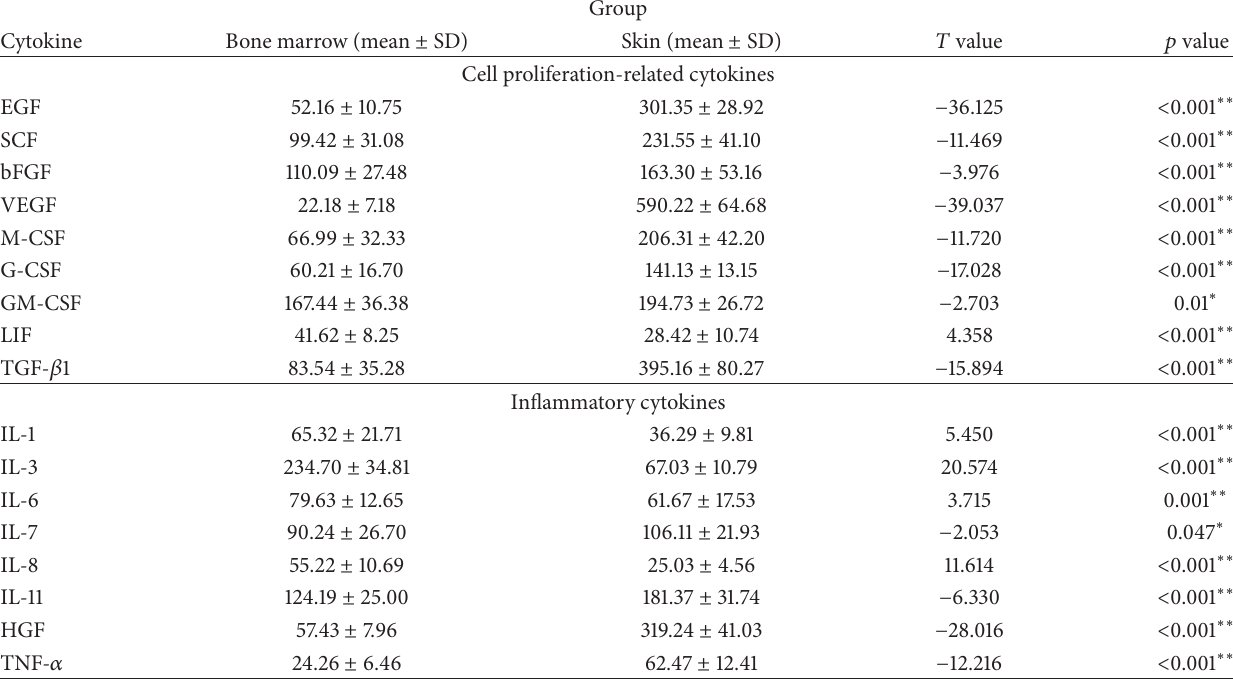
Table 2: Cytokine levels in the culture medium of MSCs isolated from the bone marrow and skin (pg/mL). Group